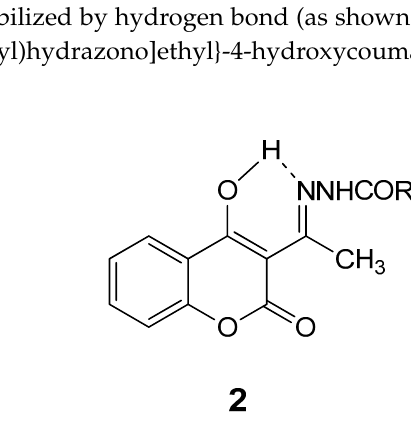
Figure 1. Hydrogen bond in 3-acetyl-4-hydroxycoumarin N -acylhydrazones.